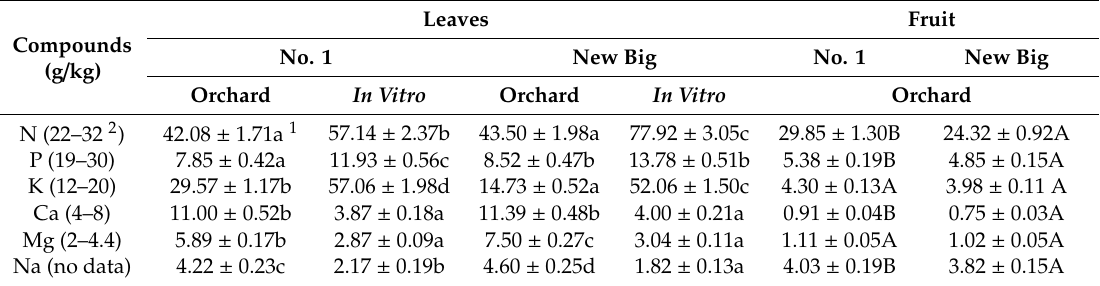
Table 1. Average values of macroelements in leaves and fruit of two cultivars of goji cultivated in orchard and in vitro